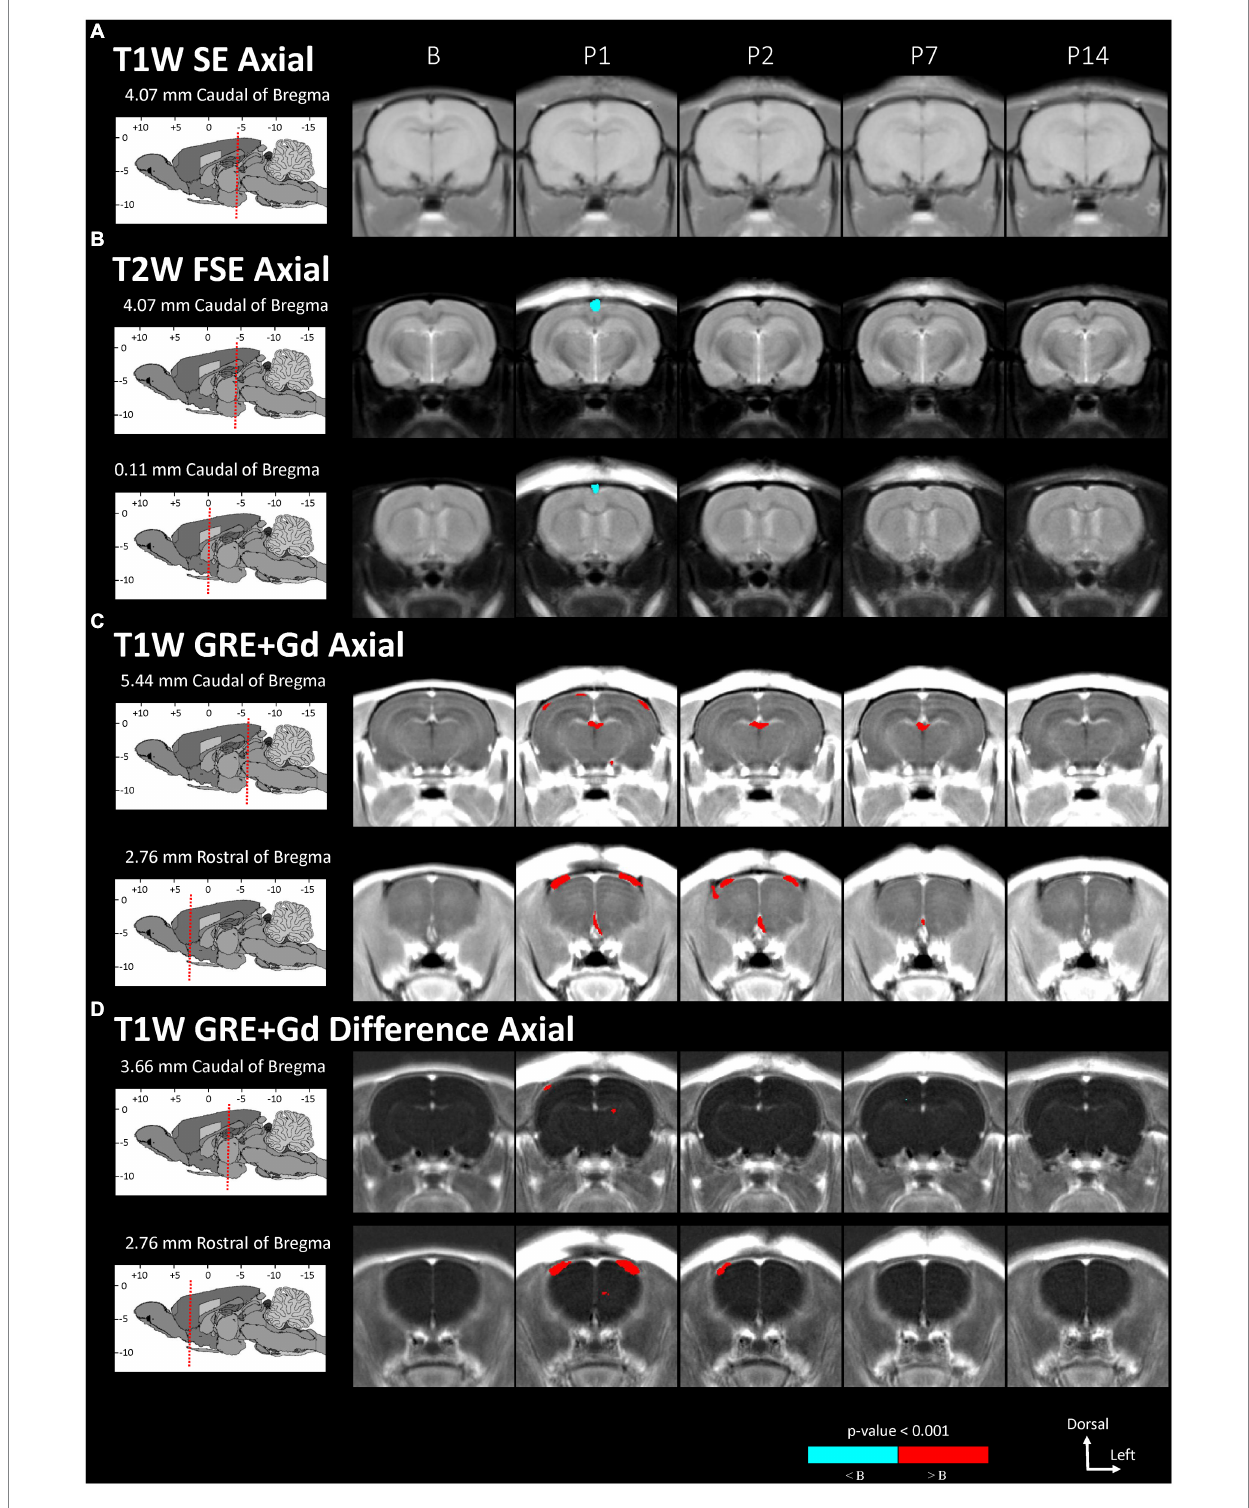
FIGURE 2 Voxel-based morphometry statistical comparisons between baseline and post-injury images grouped by day and axial scan, showing only the slices with significantly different voxel clusters for each scan (A-D) . The grayscale brain MRI underlays shown are the average signals of the images grouped by